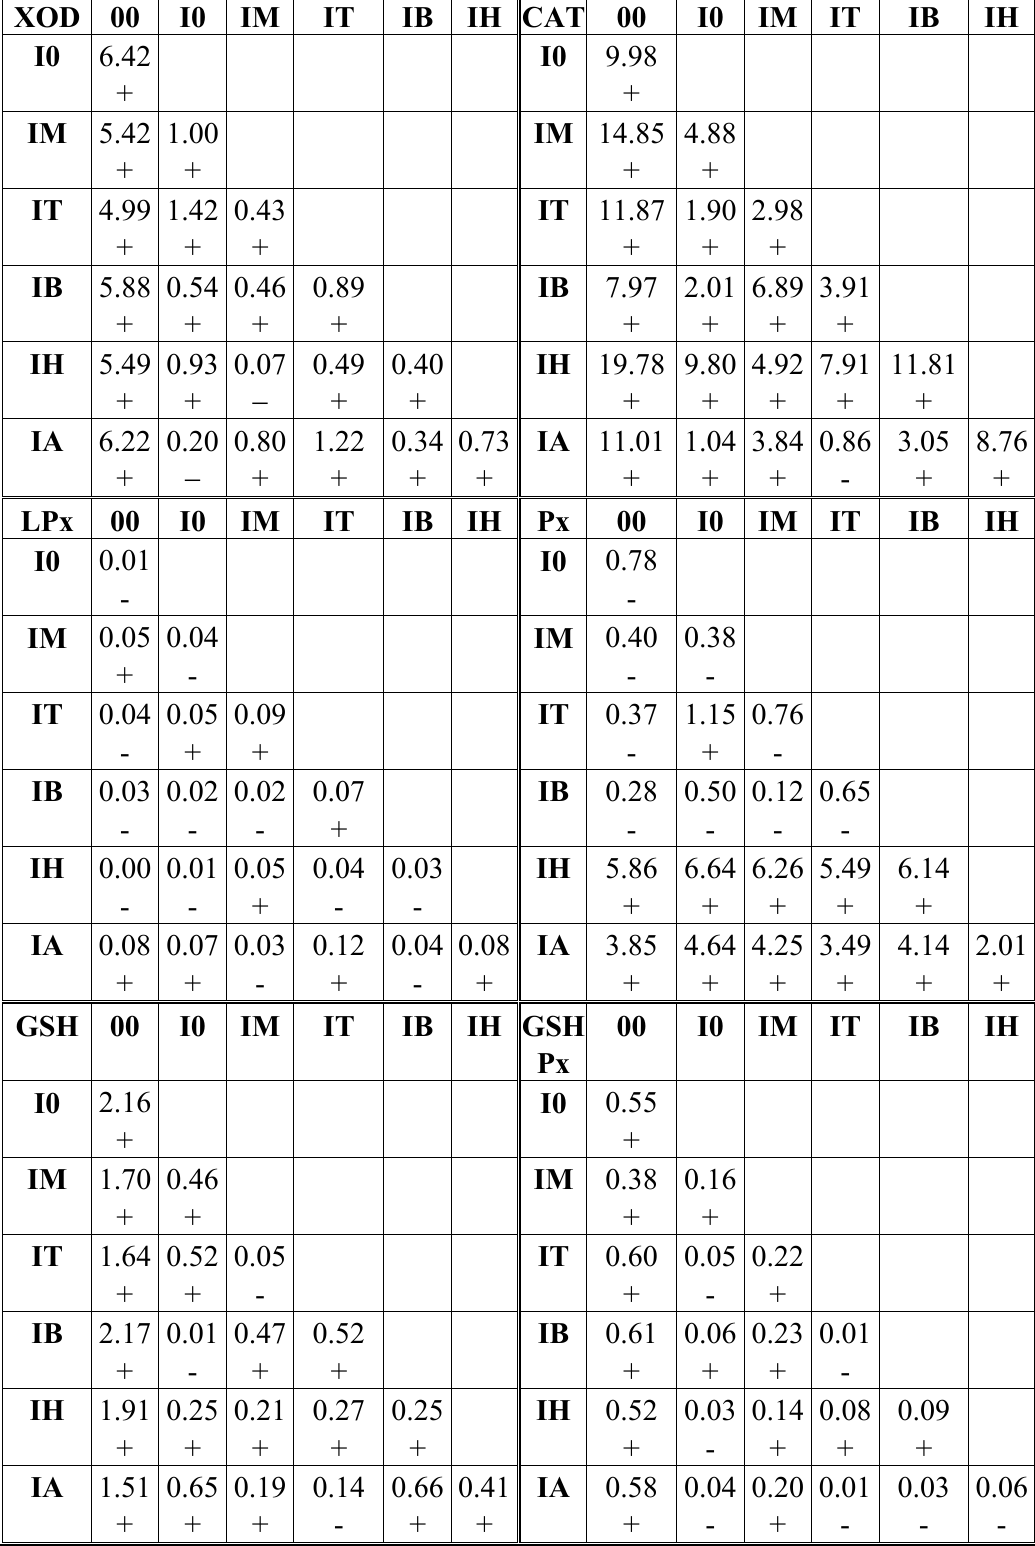
Table 2. ANOVA test for measured biochemical